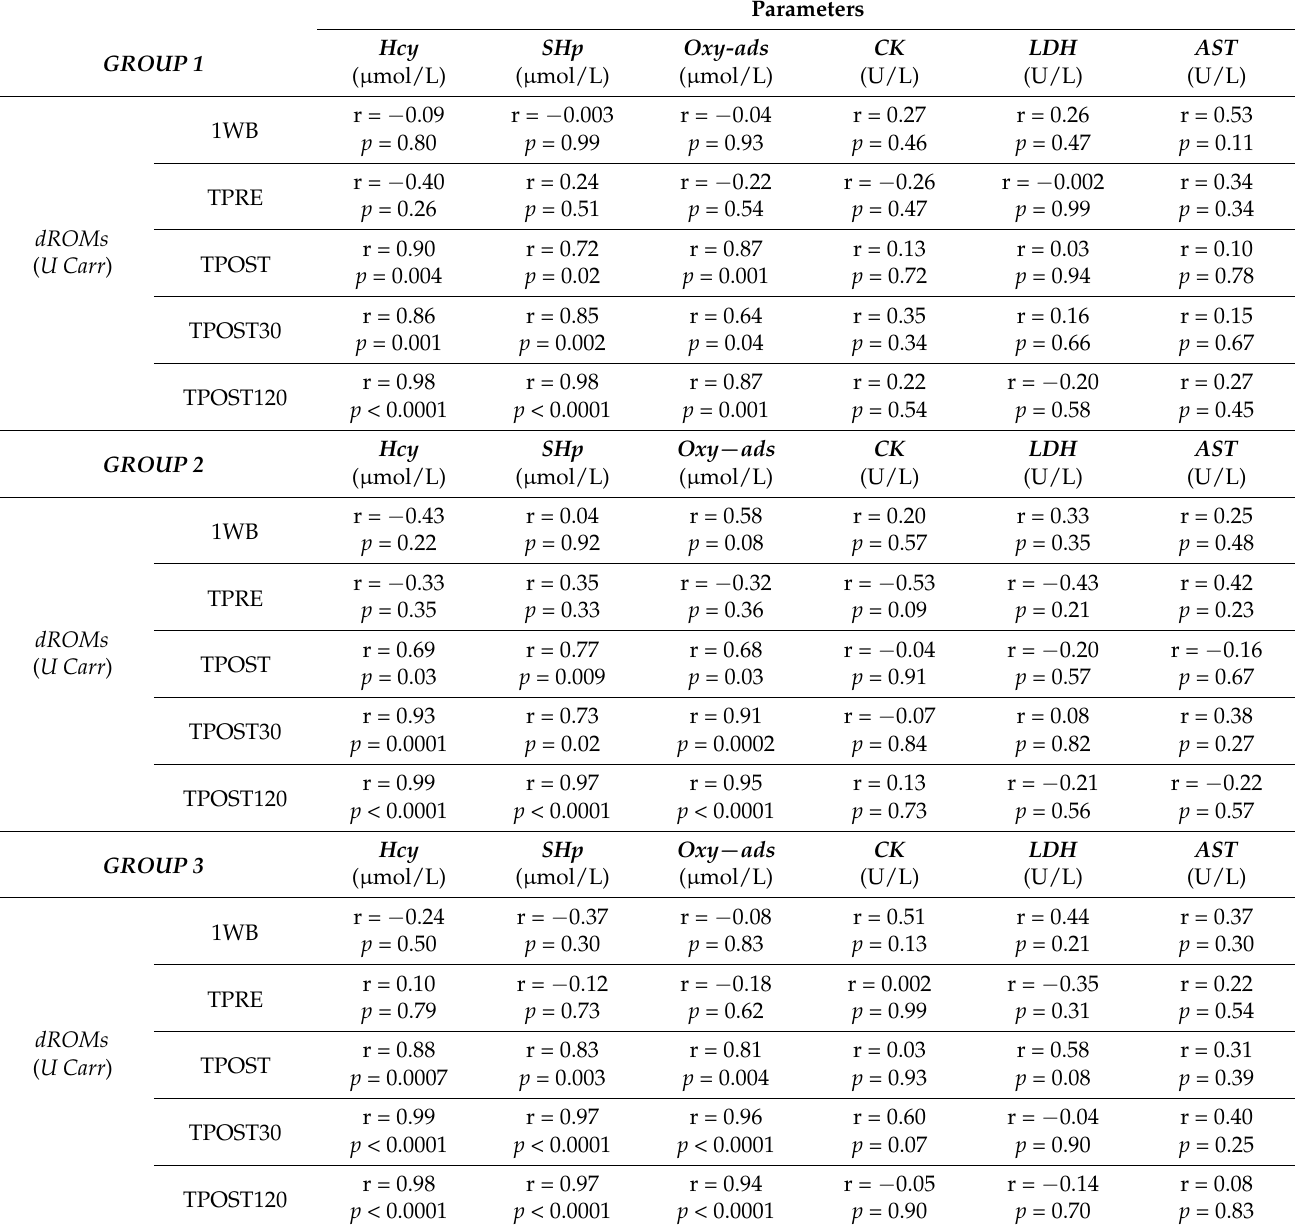
Table 2. Coefficients of correlation between the serum values of reactive oxygen metabolites (dROMs) and the levels of thiol antioxidant barrier (SHp) and antioxidant barrier (Oxy-ads), homocysteine (Hcy), creatine kinase (CK), lactate dehydrogenase (LDH) and aspartate aminotransferase (AST) obtained from racehorses competing in official races of 1200 (Group 1), 1600 (Group 2) and 2000 m (Group 3). Blood samples were collected from each horse 1 week prior to the race (1WB), the day of the race at rest (TREST), immediately after the race (TPOST), and after 30 (TPOST30) and 120 min (TPOST120). p -values < 0.05 were considered statistically